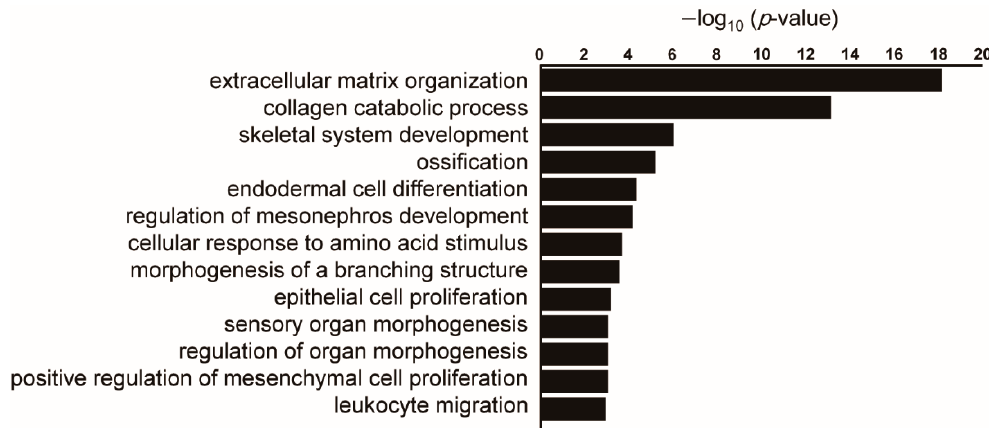
Figure 2. Pathway analysis of genes commonly upregulated in lung cancer stroma and interstitial pneumonia compared to normal lung tissues. Public datasets of gene expression profiling in lung cancer stroma (GSE22863) and interstitial pneumonia (GSE47460) were compared. When the top 1000 significantly upregulated genes in each dataset were compared, 101 genes were common between these two datasets. Enriched gene ontology terms for biological process were sorted by –log10 ( p -value). When there are several similar terms such as “extracellular matrix organization” and “extracellular structure organization”, one term with a lower p-value was selected.